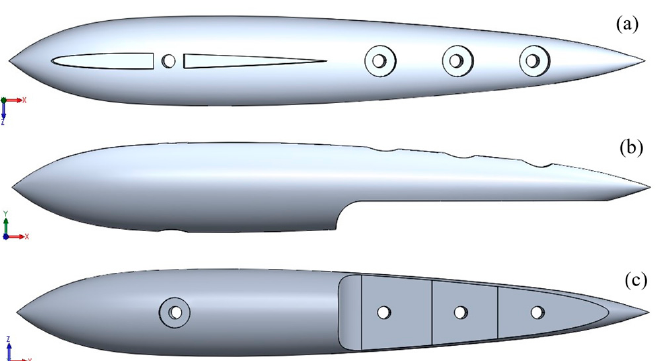
Figure 2. Bulb 3D base model views, ( a ) top, ( b ) side, ( c ) bottom. The overall longitudinal length of the component is 290 mm .